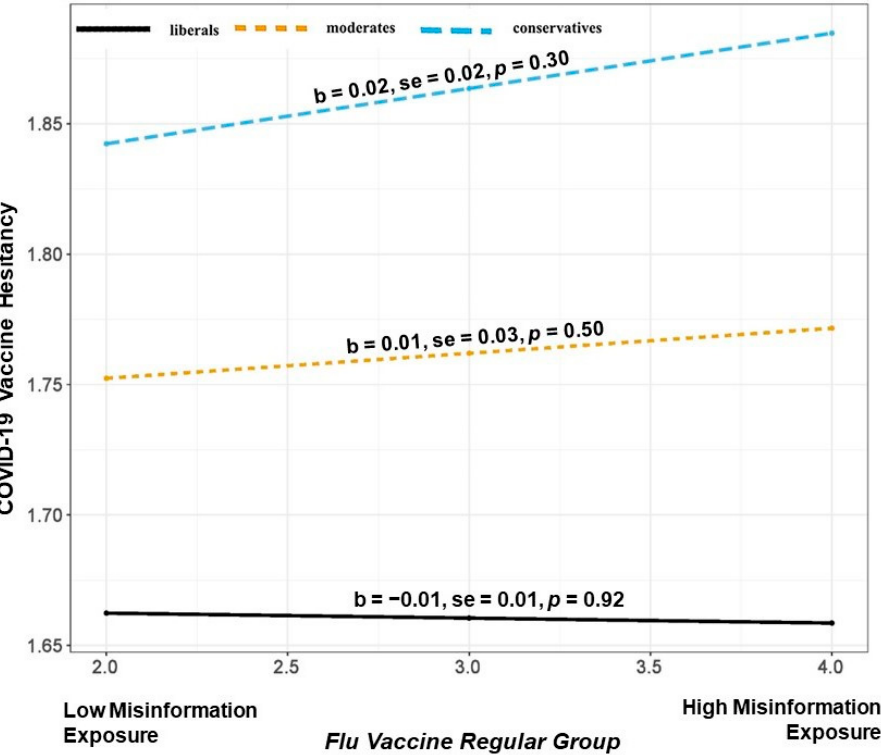
Figure 4. Illustration of the interaction between perceived misinformation exposure and political ideology in predicting COVID-19 vaccine hesitancy for the flu vaccine regular group.